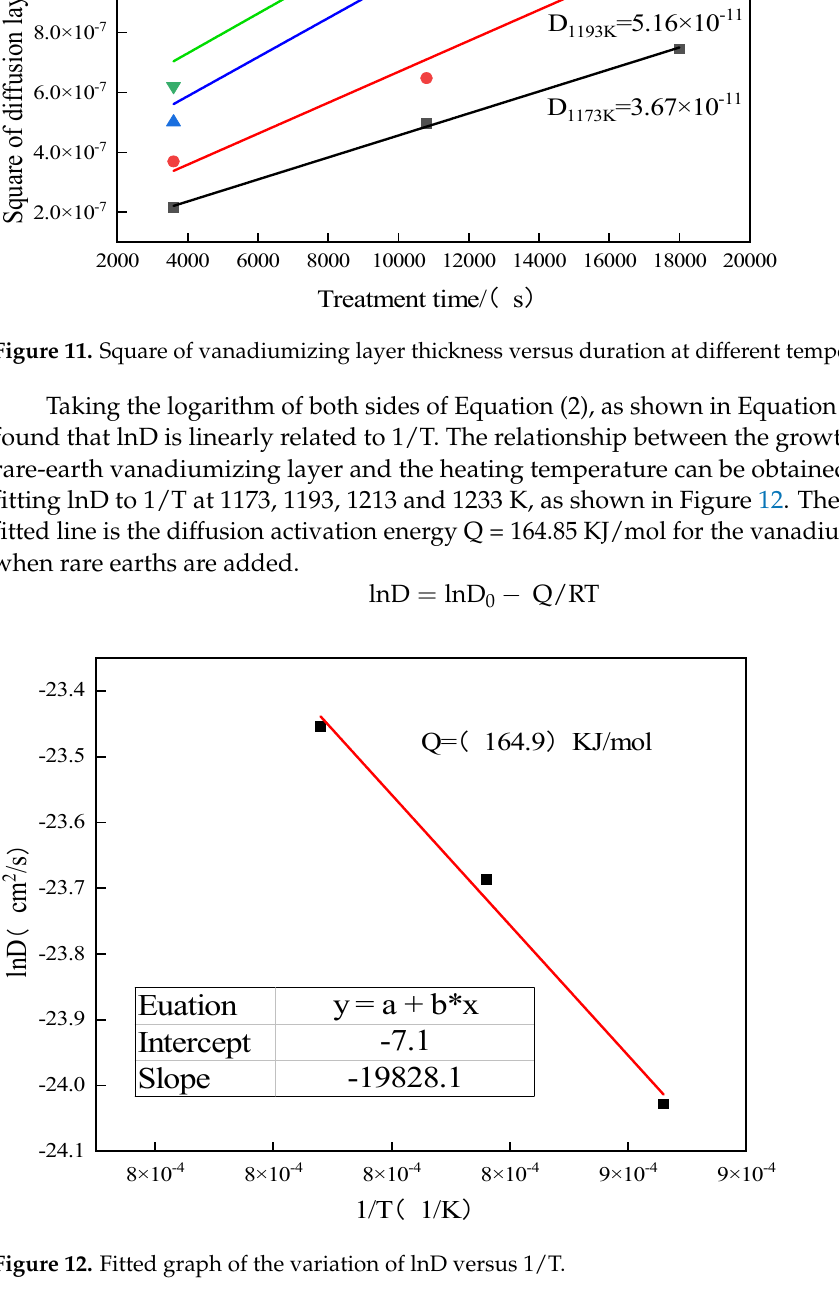
Figure 12. Fitted graph of the variation of lnD versus 1/T. Table 2. D 0 and Q of vanadiumizing layer under different substrate conditions.